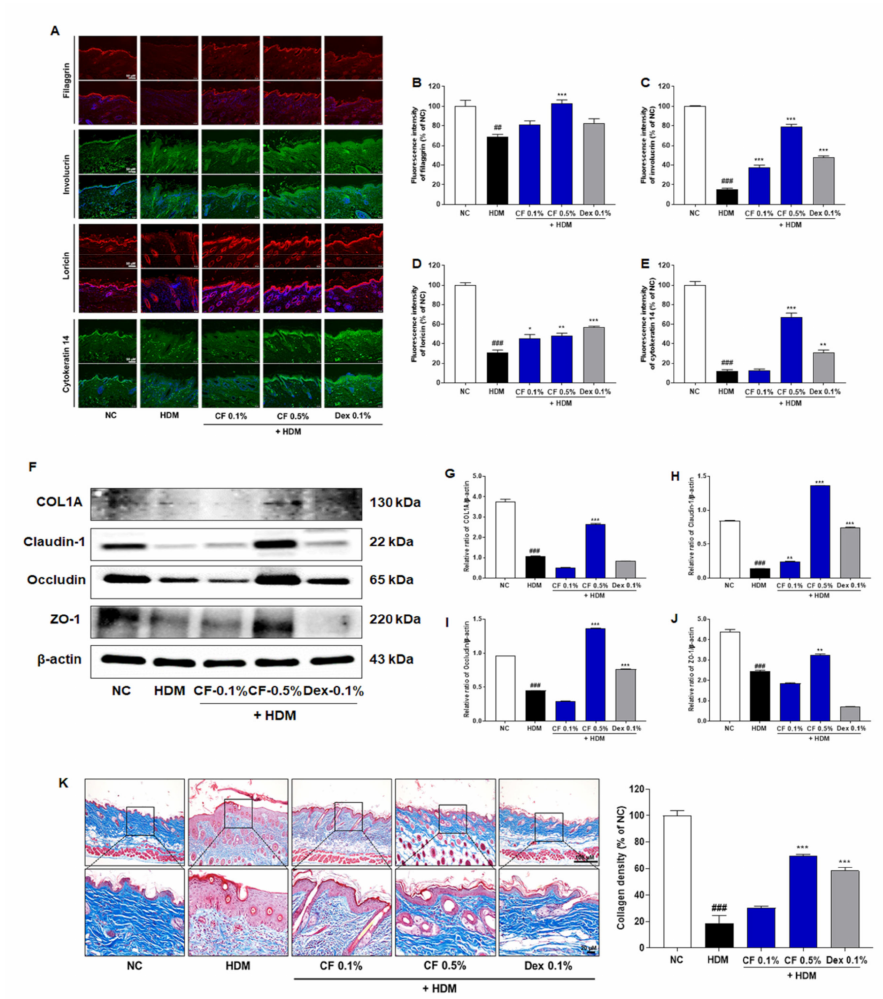
Figure 2. CF improves skin barrier function-related proteins and collagen formation in the HDM- induced AD mouse model. ( A ) Filaggrin, involucrin, loricrin, and cytokeratin 14 levels were eval- uated by immunofluorescence in dorsal skin tissue. Scale bar = 50 µ m. A quantitative analysis of dorsal skin tissue levels of ( B ) filaggrin, ( C ) involucrin, ( D ) loricrin, and ( E ) cytokeratin 14 levels. ( F ) COL1A, claudin-1, occludin, and ZO-1 were analyzed in dorsal skin tissue by western blotting. Bar graphs represent the relative expression levels of ( G ) COL1A, ( H ) claudin-1, ( I ) occludin, and ( J ) ZO-1. Relative expression levels were obtained by normalization against β -actin. ( K ) Representative micrographs of skin tissue sections stained with Masson’s trichrome for collagen after HDM induc- tion for 6 weeks (Scale bar = 100 µ m or 20 µ m). Quantitative analysis of collagen density. All data are presented as means ± SEM ( n = 6 mice per group). Statistical differences were evaluated by one-way ANOVA, with Dunnett’s post-hoc tests; ## p < 0.01 and ### p < 0.001 compared with the NC group; * p < 0.05, ** p < 0.01, and *** p < 0.001 compared with the HDM